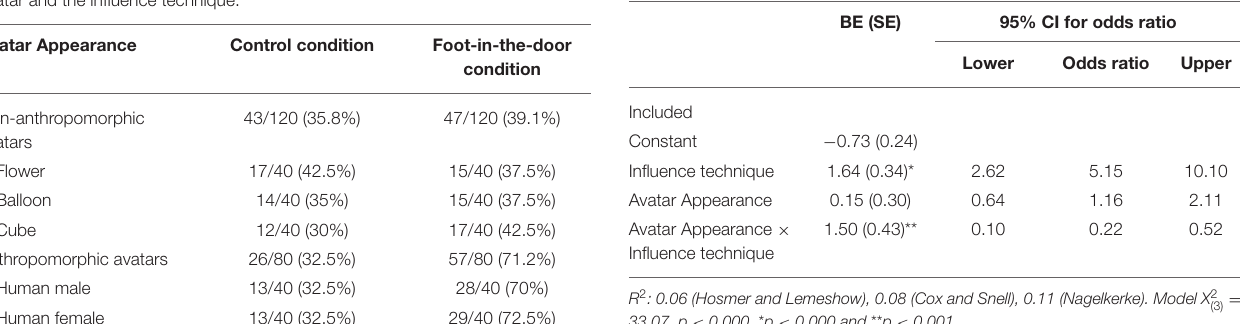
TABLE 1 | Compliance rate (%) according to the appearance of the experimenter avatar and the influence technique.